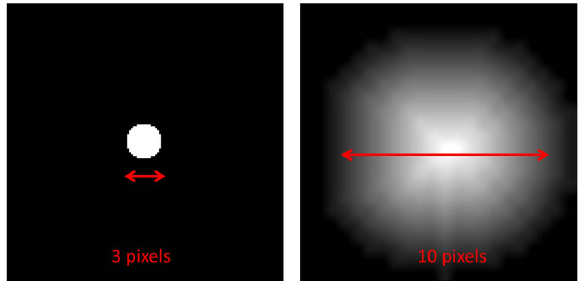
Figure 3. Binary (left) and distance transform (right)